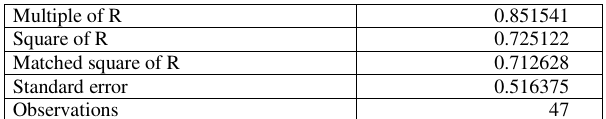
Table 5. Regression statistics of the equation (13) in reference to fuel consumption model of cars with compression ignition engines